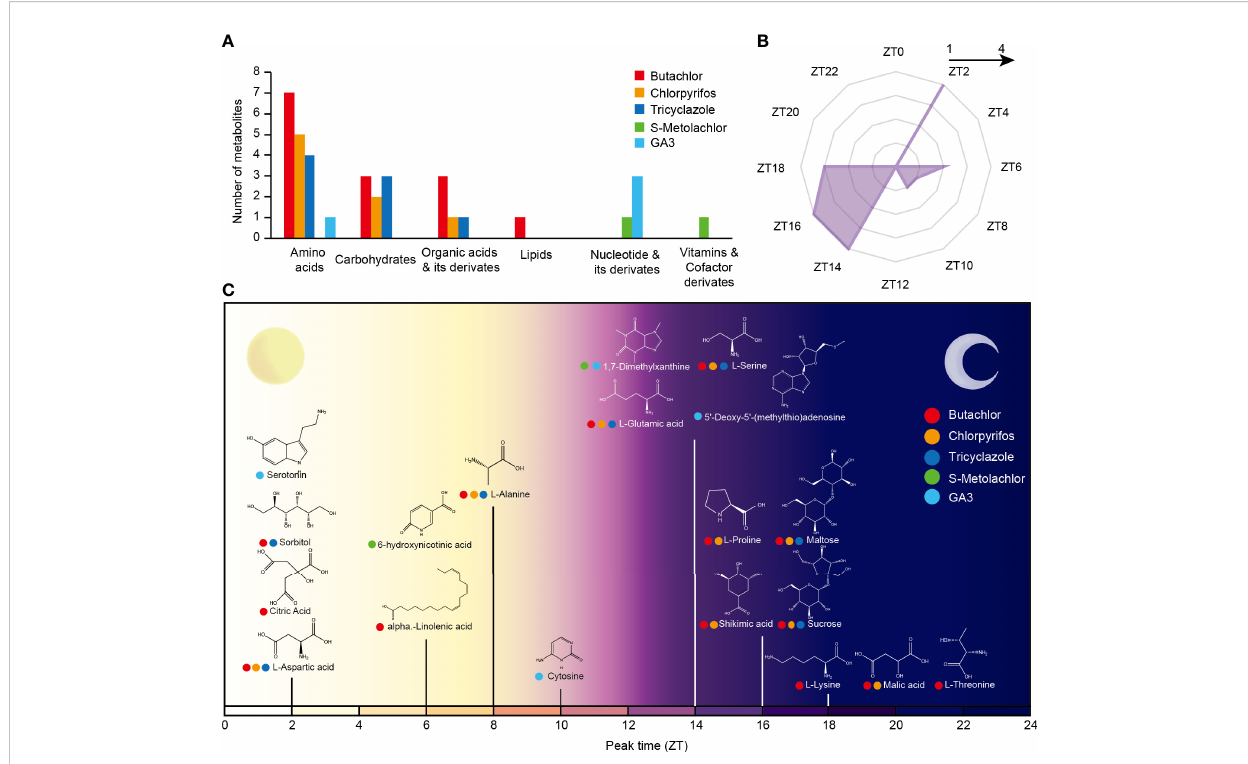
FIGURE 2 The crosstalk of rice circadian rhythm and pesticides response processes at metabolome level. (A) Number of various CRMs in response to the application of different pesticides. (B) Circadian phase distribution of pesticides responsive CRMs. The coordinates of each angle represent phases ZT0 – ZT24. The inner to outer circles represent 1-5 metabolites reaching peak expression at that time point, respectively. (C) Time of peak accumulation of pesticides responsive CRMs. The x-axis represents the circadian phase of the metabolite. The different colors of the circles on the left of the metabolite ’ s name represent its response to different pesticides.